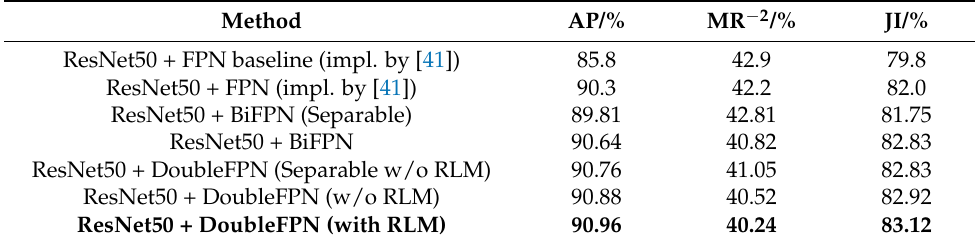
Table 2. Ablation study implemented on the validation set of CrowdHuman.